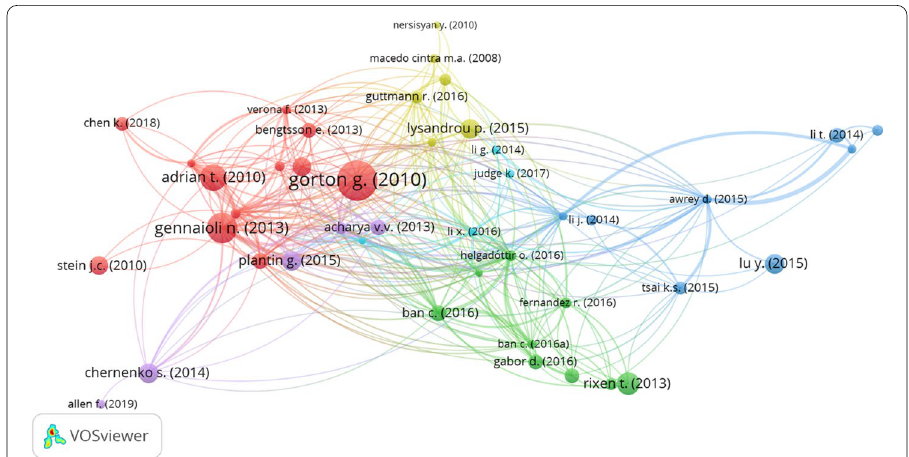
Fig. 7 Network visualization of bibliographic coupling of documents. Source : Authors’ own